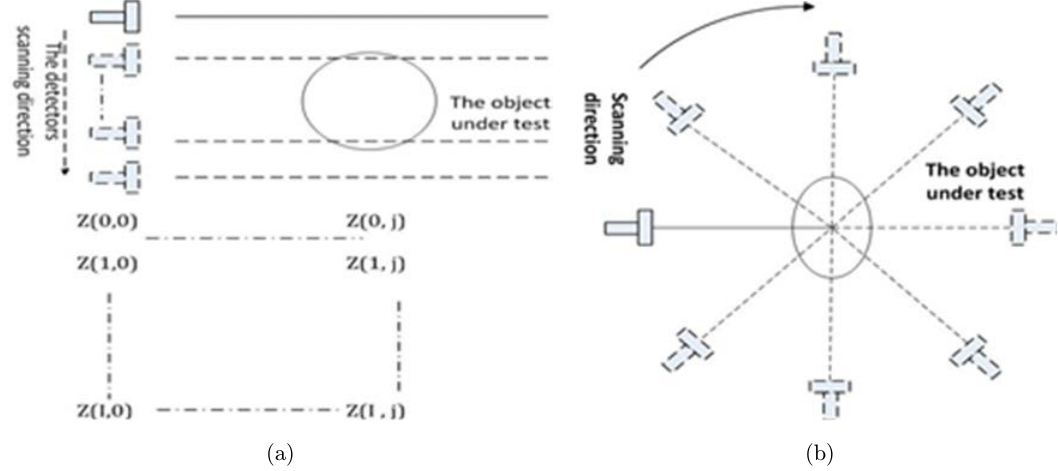
Fig. 8. Schematic diagram of LS (a) and CS